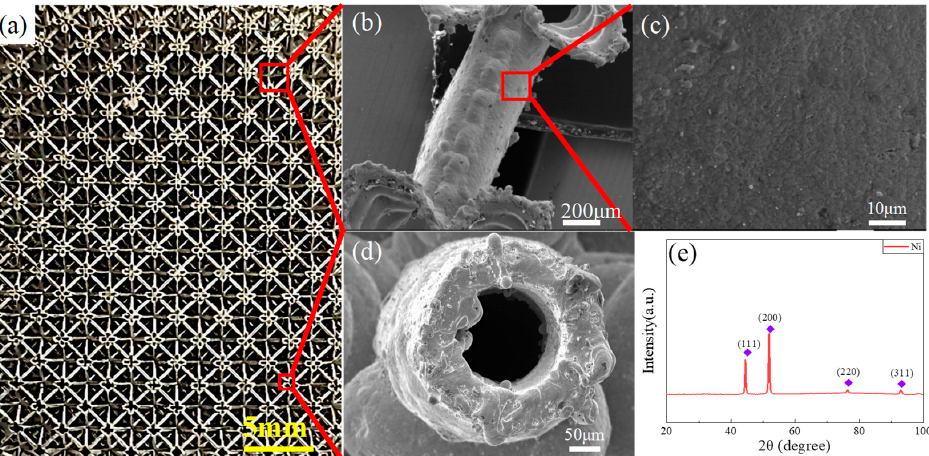
Figure 2. ( a ) Macroscopic pictures of hollow nickel lattices; ( b – d ) Hollow lattice surface and cross- sectional topology; ( e ) XRD pattern of electrodeposition